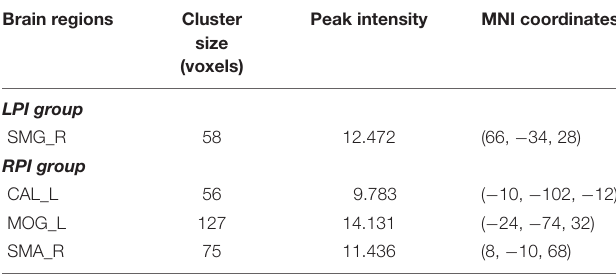
TABLE 3 | Brain regions with longitudinal CBF changes.